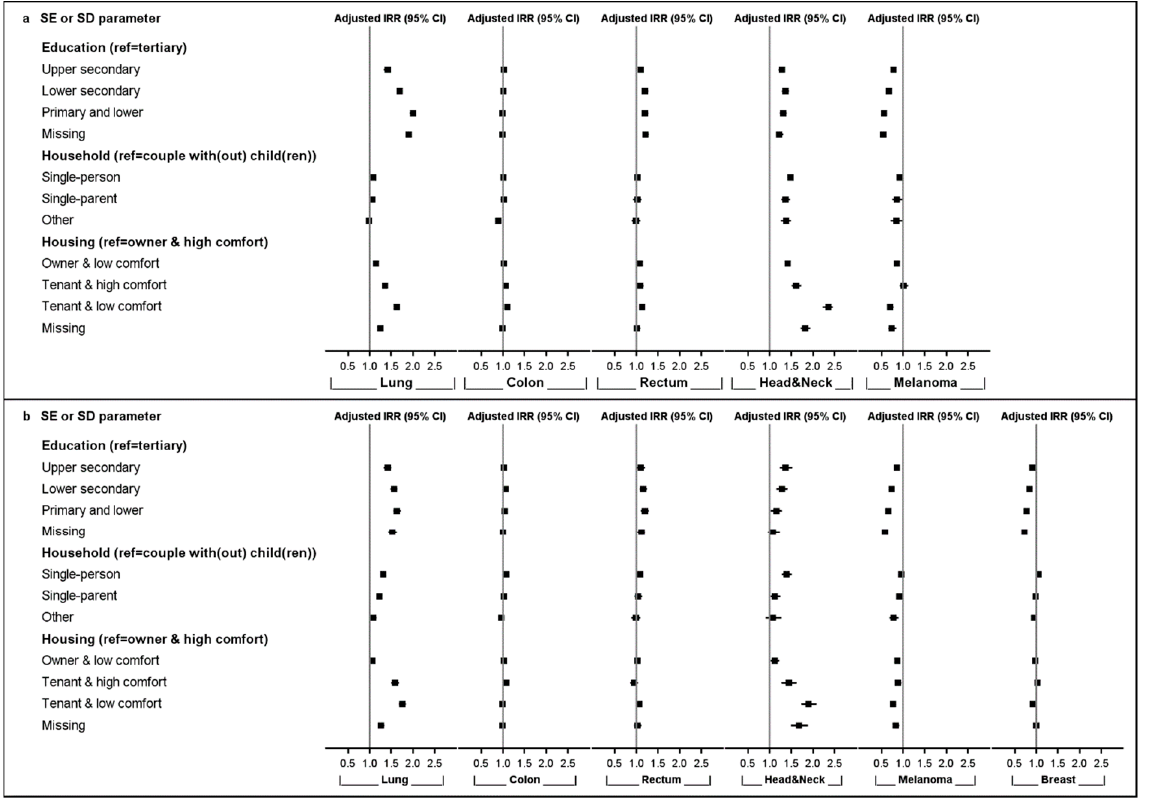
Figure 1. Adjusted incidence rate ratios (IRRs) with a 95% confidence interval (CI) by socio-economic (SE) or -demographic (SD) parameters, cancer type, and sex; 2004–2013. Upper panel ( a ): men; lower panel ( b ): women.